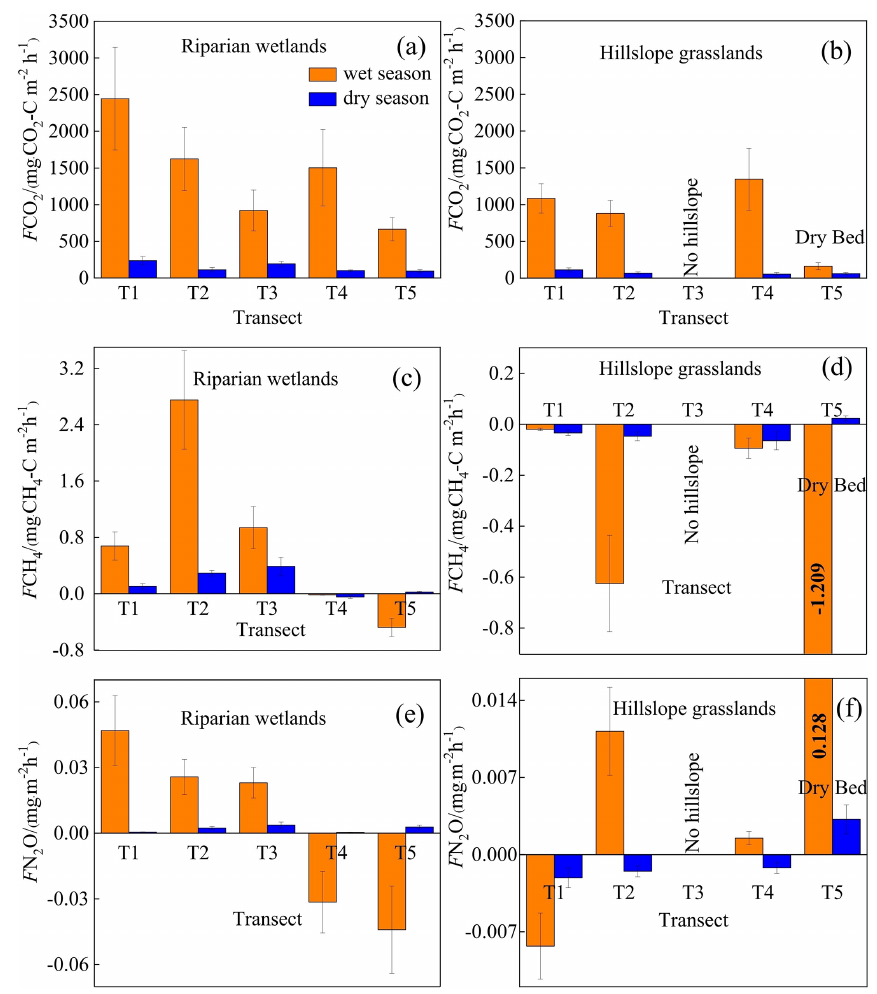
Figure 6. Spatiotemporal patterns of CO 2 (first line), CH 4 (second line), and N 2 O (third line) emissions ( F ) in the upstream (T1, T2, and T3) and downstream areas (T4 and T5). Bars represent the mean values for each transect, and error bars show the standard